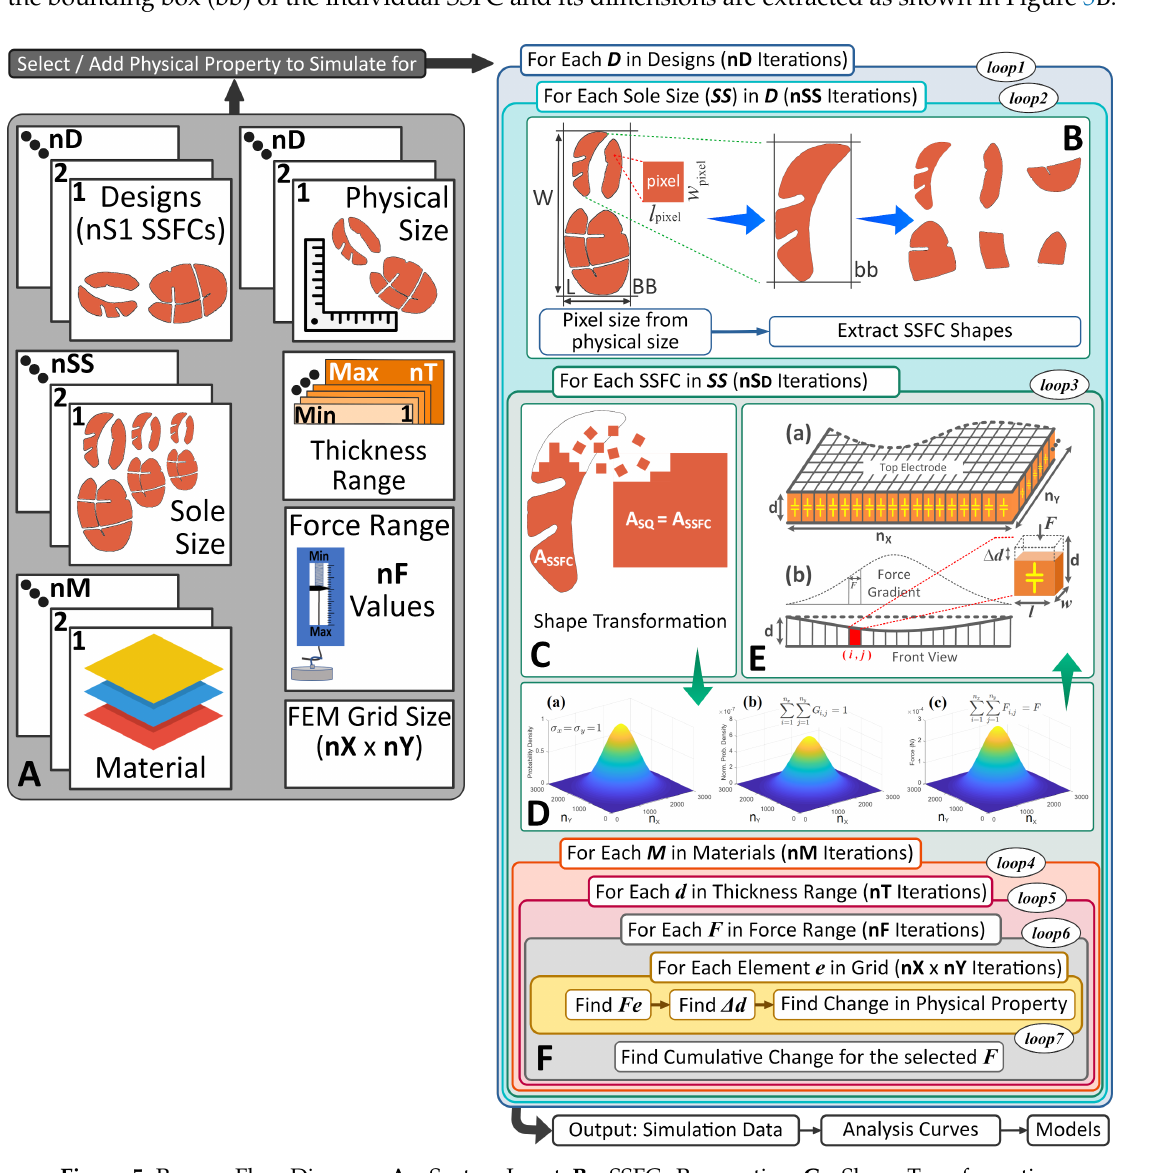
Figure 5. Process Flow Diagram: A —System Input, B —SSFCs Preparation, C —Shape Transformation to a Regular Shape, D —( a ) Gradient of Normal Distribution ( b ) Normalized Gradient ( c ) Mapped Force Gradient for F = 450N, E —( a ) Grid of N Capacitive Elements ( b ) Thickness of Elements under Force Gradient., F —Cumulative Change for a Selected